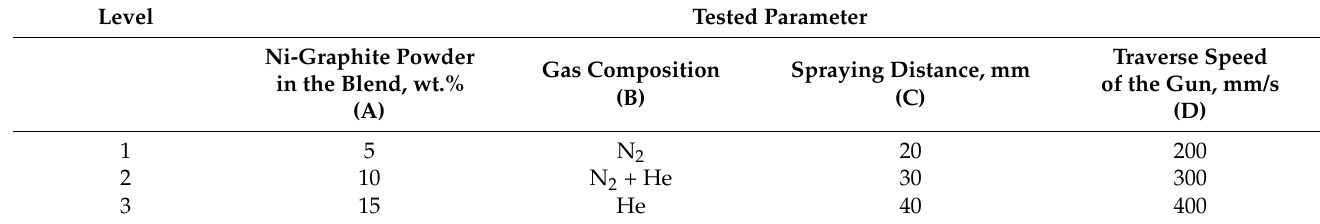
Table 1. Levels of tested